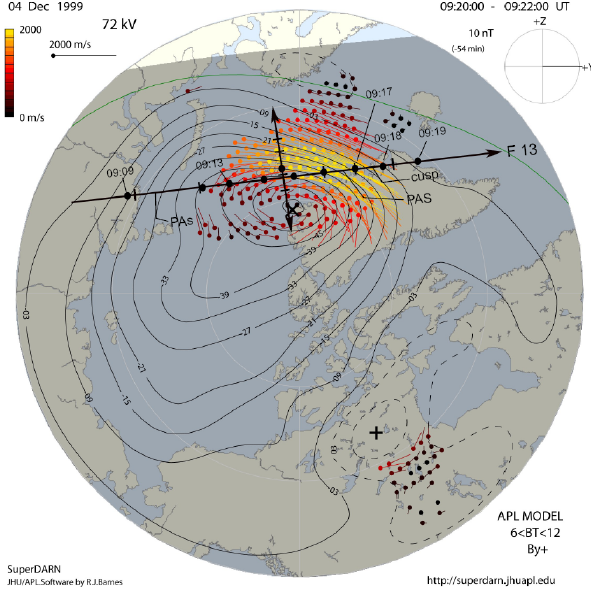
Fig. 13. SuperDARN convection data obtained during the interval 09:00–09:02UT. Same format as in Fig. 8.